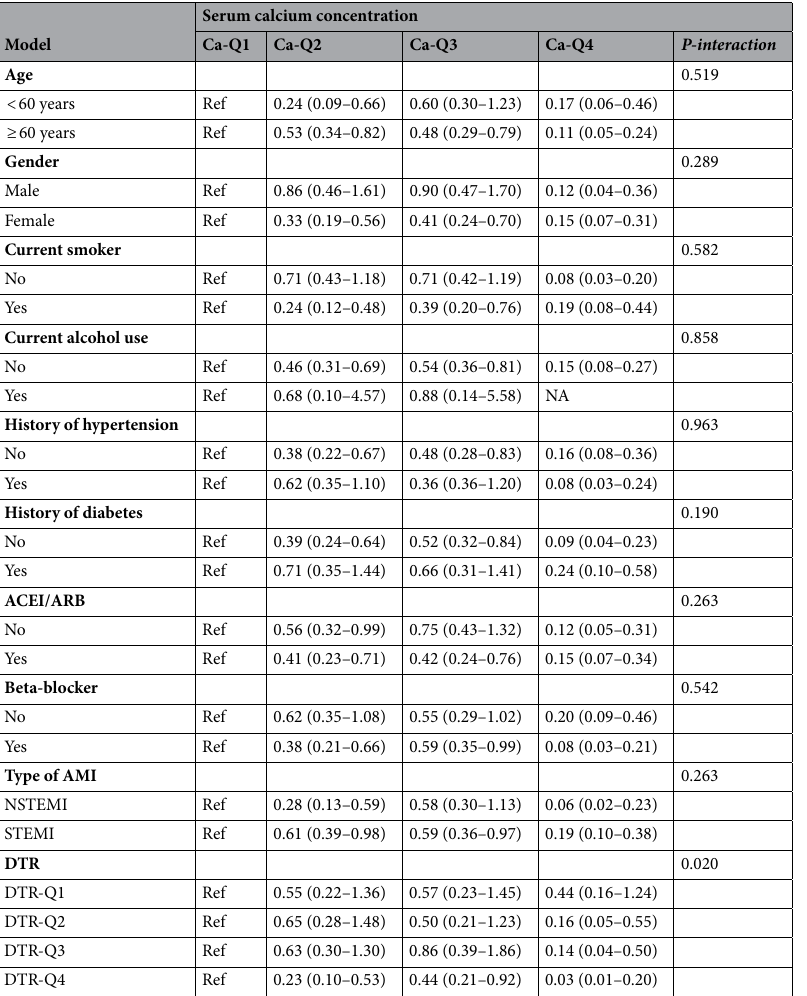
Table 3. The association between serum calcium concentration and in-hospital mortality of patients with acute myocardial infarction: subgroup